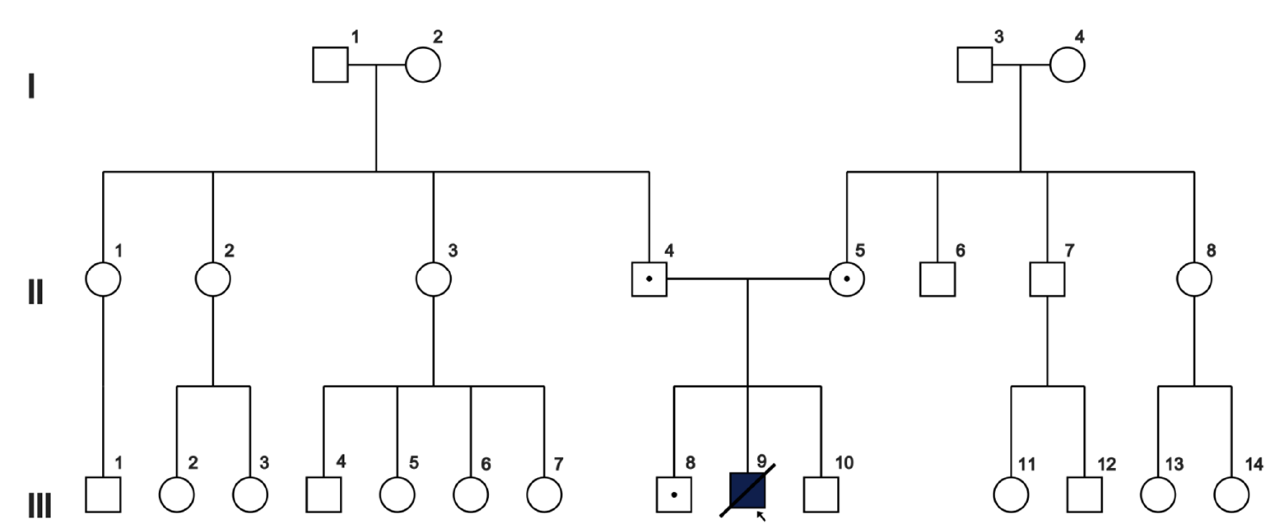
Figure 1. Pedigree of the family under study. The affected individual III9 is homozygous for the paternal c.471_477delTTTAAAAinsG and the maternal c.471_477delTTTAAAAinsG MOCS2 mutations.